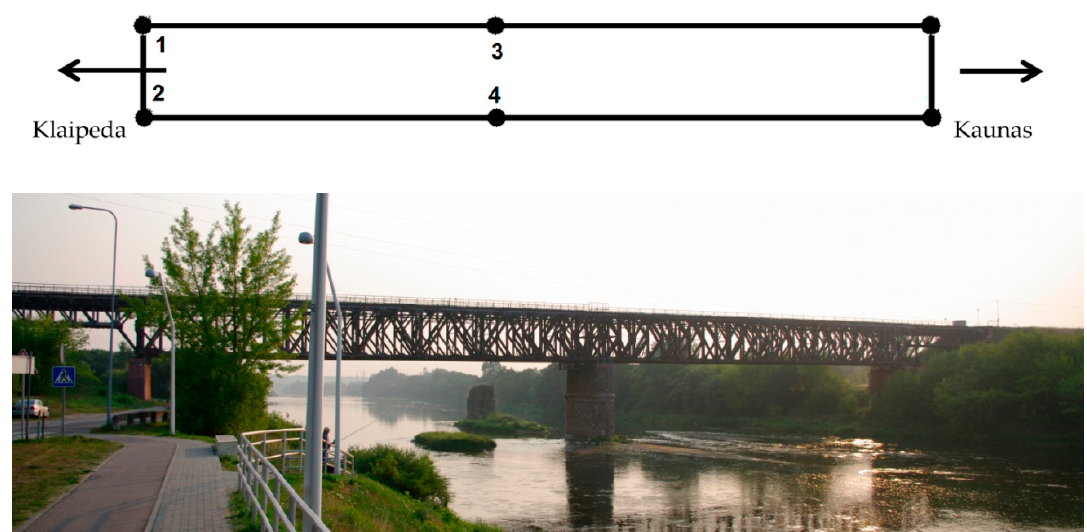
Figure 1. Layout of the points of measurement in the bridge structure. Figure 2. Layout of the points of measurement in the bridge structure.